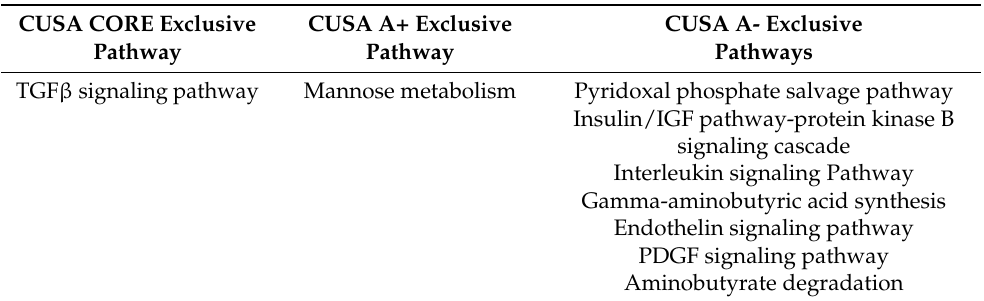
Table 6. List of the molecular pathways exclusively classified in R GBM CUSA CORE, CUSA A+, and CUSA